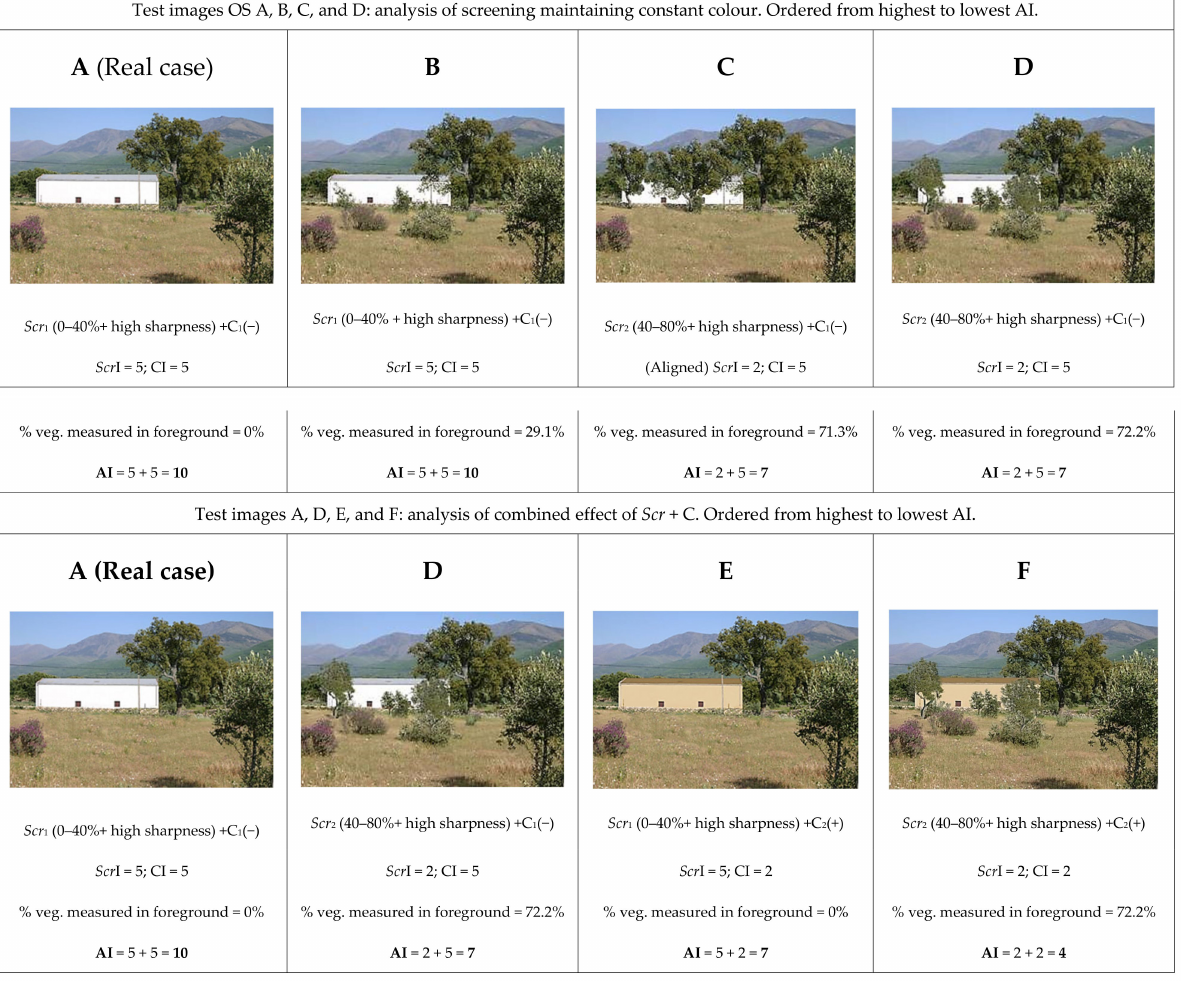
Figure 4. Survey images used with group 2 participants (agricultural buildings). The variable screening ( Scr ) presents two levels of change in the percentage of vegetation in front of the building (0–40% or 40–80%). The variable colour (C) presents two study proposals: (+) positive impact of building colour of less than 3 points; ( − ) negative impact of building colour of more than 3